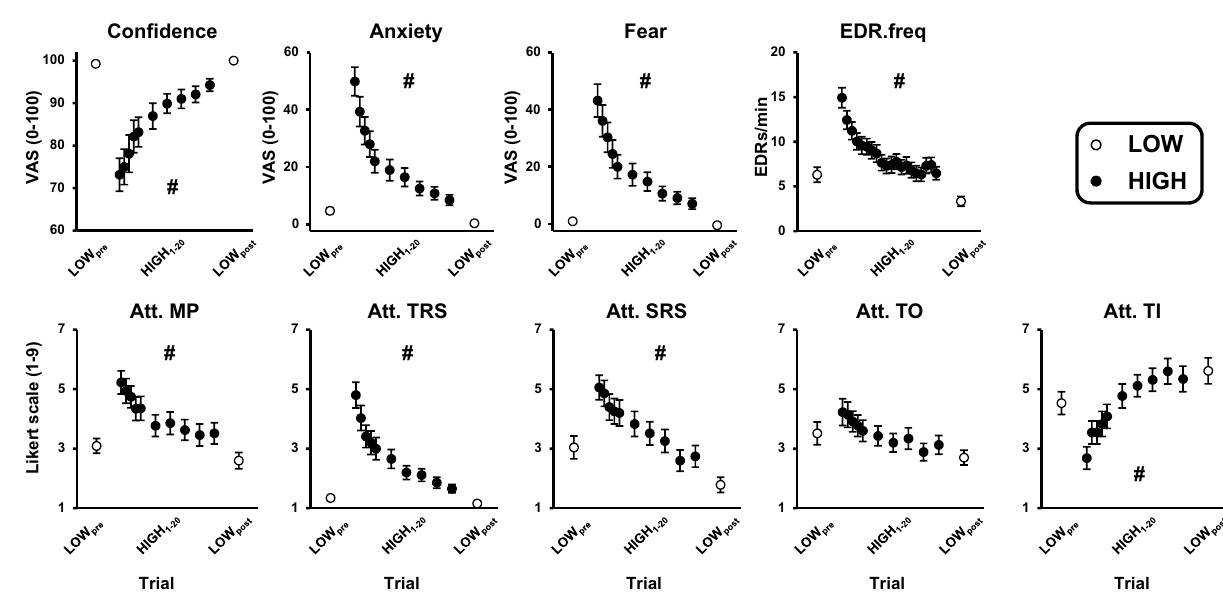
Figure 2. Effect of threat and trial on psychological and autonomic outcomes. Data presented reflect group means and standard errors. The first two and last two LOW trials have been averaged (LOW pre and LOW post , respectively) and are represented as open circles, while data across HIGH trials 1–20 are represented as filled black circles. Note, self-reported measures at the HIGH condition were only collected on trials 1-5, 8, 11, 14, 17, and 20 as illustrated. Att. = attention toward; EDR.freq = non-specific electrodermal response frequency; MP = movement process; SRS = self-regulatory strategies; TI = task-irrelevant information; TO = task objectives; TRS = Threat-related stimuli; VAS = visual analog scale. Hashtags indicate significant threat × trial interactions resulting from a reduced effect of threat as a function of repeated